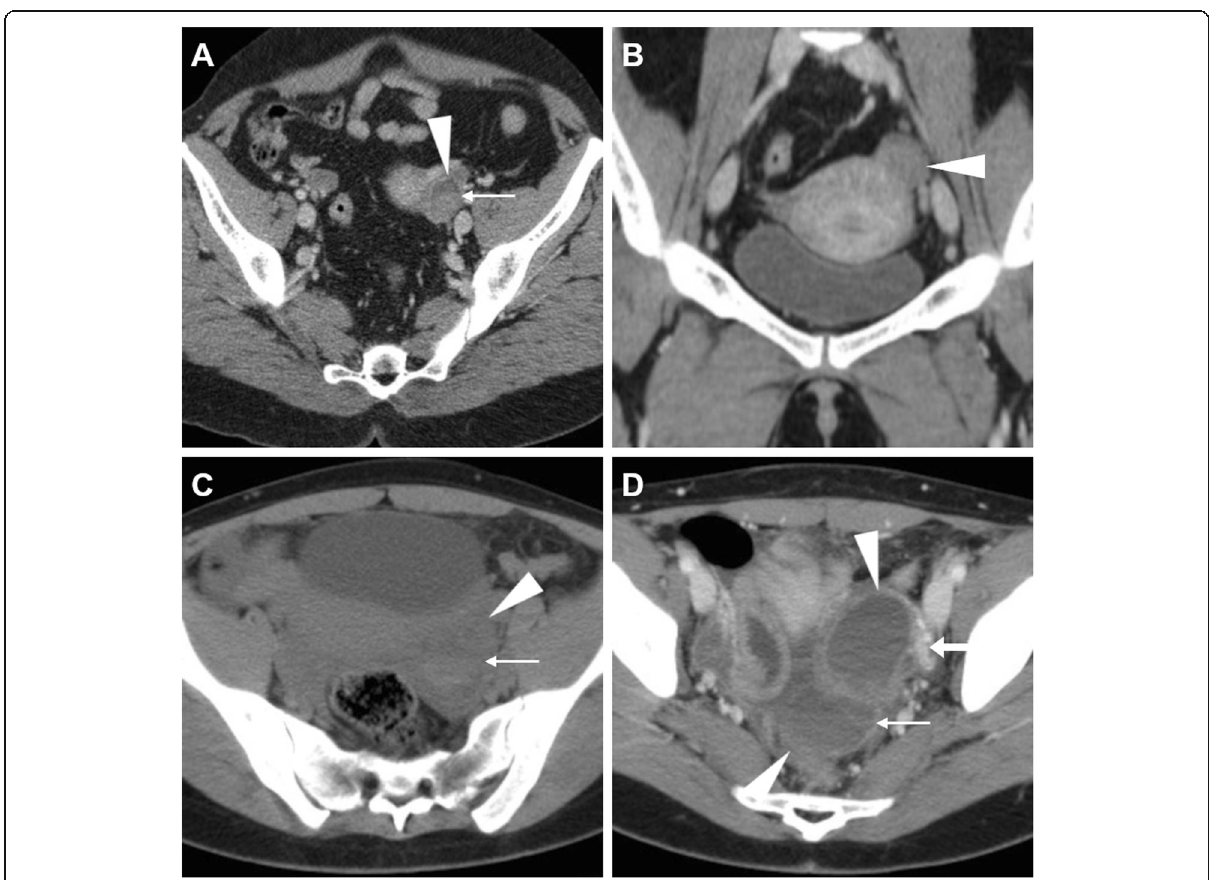
Fig. 6 Two CT cases of haemorrhagic ovarian cysts. a , b The normal-sized left ovary (arrowheads) show mixed appearance with dependent high attenuation and fluid-fluid level (thin arrow in a ) consistent with haemorrhagic corpus luteum. c , d Unenhanced ( c ) and post-contrast ( d ) images show a larger, bilocular adnexal lesion (arrowheads) with thin regular peripheral enhancement and dependent hyperattenuation (thin arrows). Note the ovarian vessels (arrow in d